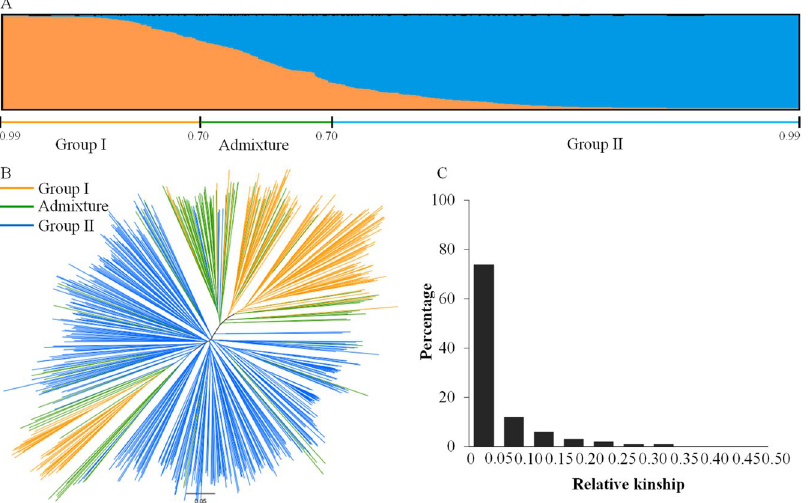
Figure 3. Population genetic structure ( A , B ) and relative kinship ( C ) of the materials. ( A ) Result of STRUCTURE analysis; ( B ) Result of NJ analysis with colored branches based on STRUCTURE analysis; and ( C ) Distribution of the kinship